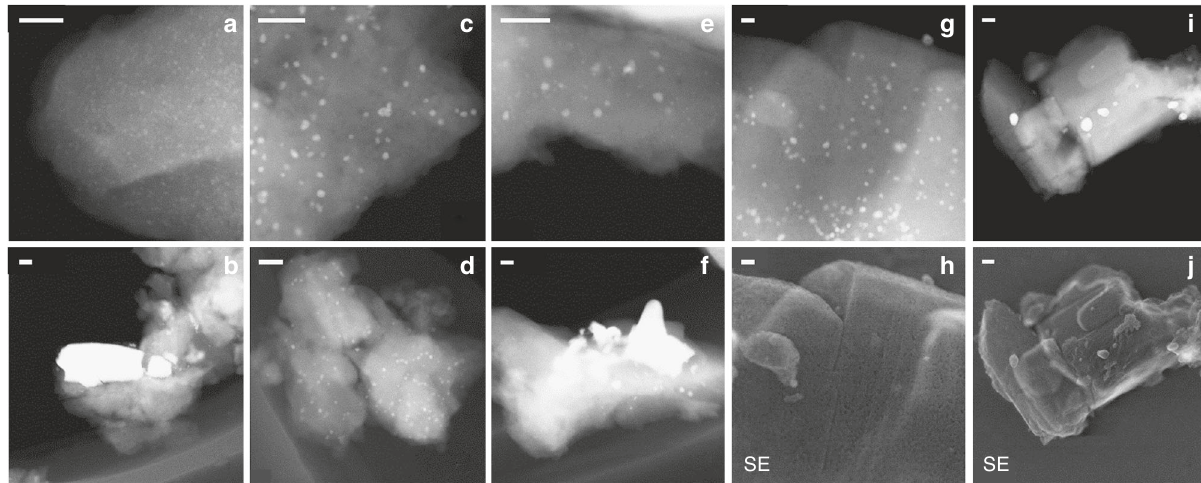
Fig. 2 Representative electron microscopy images of calcined and spent catalysts. a , b Pd/H-MOR, c , d Pd/Na-MOR, e , f Pd/H-MOR-BE. Spent catalysts were aged in 1 vol% CH 4 , 4 vol% O 2 , 5 vol% H 2 O, N 2 bal. at 415 °C for 16 h. STEM and secondary electron (SE) images of g , h Pd/Na-MOR and i , j Pd/H- MOR after 90 h and 65 h on stream, respectively, continuous with short pulse regeneration. Scale bar: 20 nm ( a – h ) and 50 nm ( i , j )